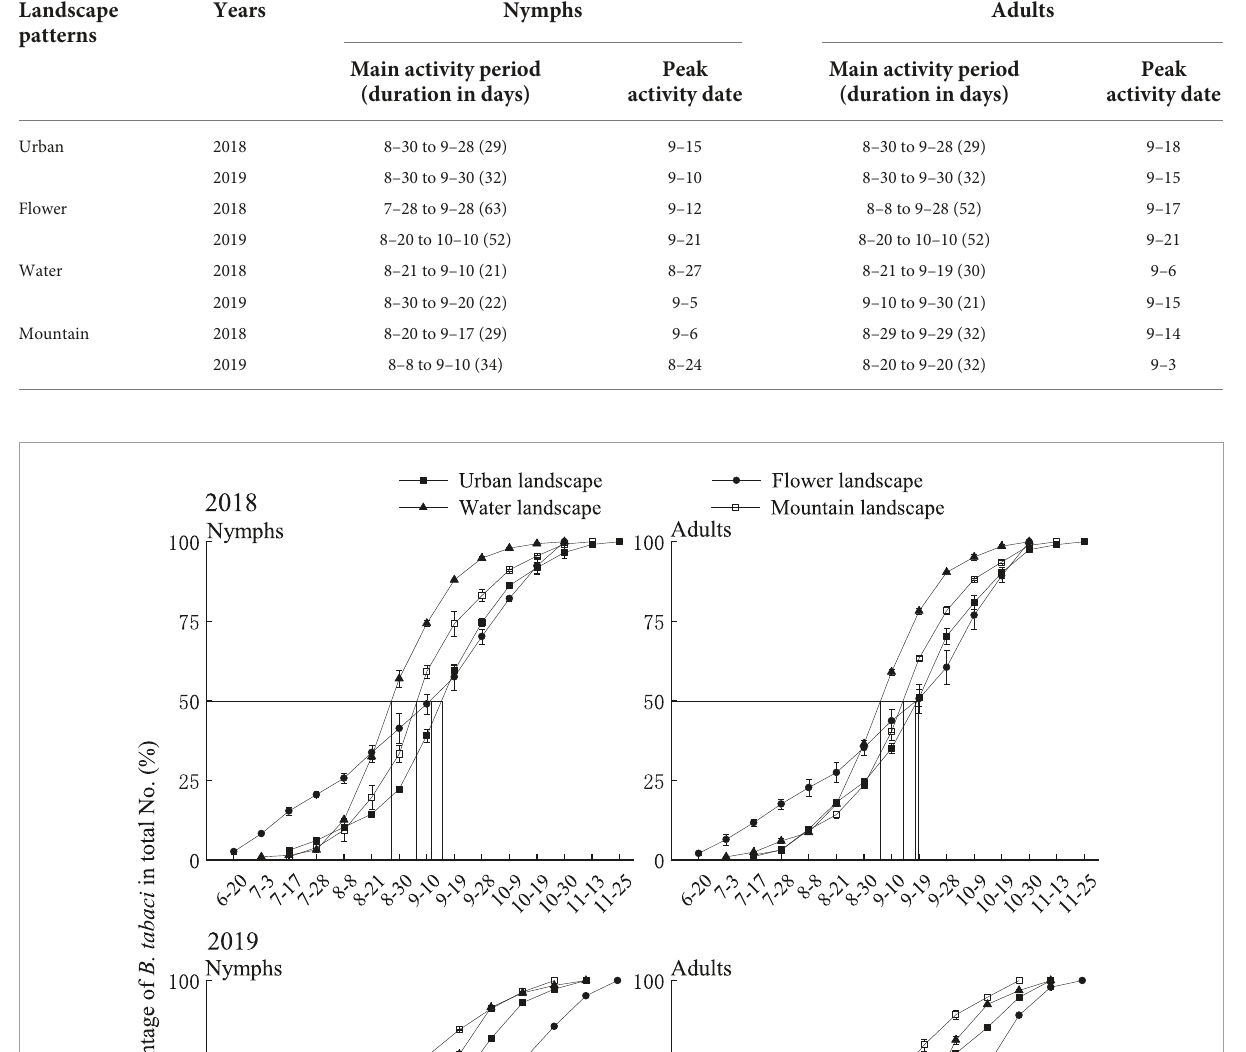
TABLE 4 The main activity period and dates of peak activity of nymph and adult Bemisia tabaci on summer tomato fields in different agricultural landscapes.